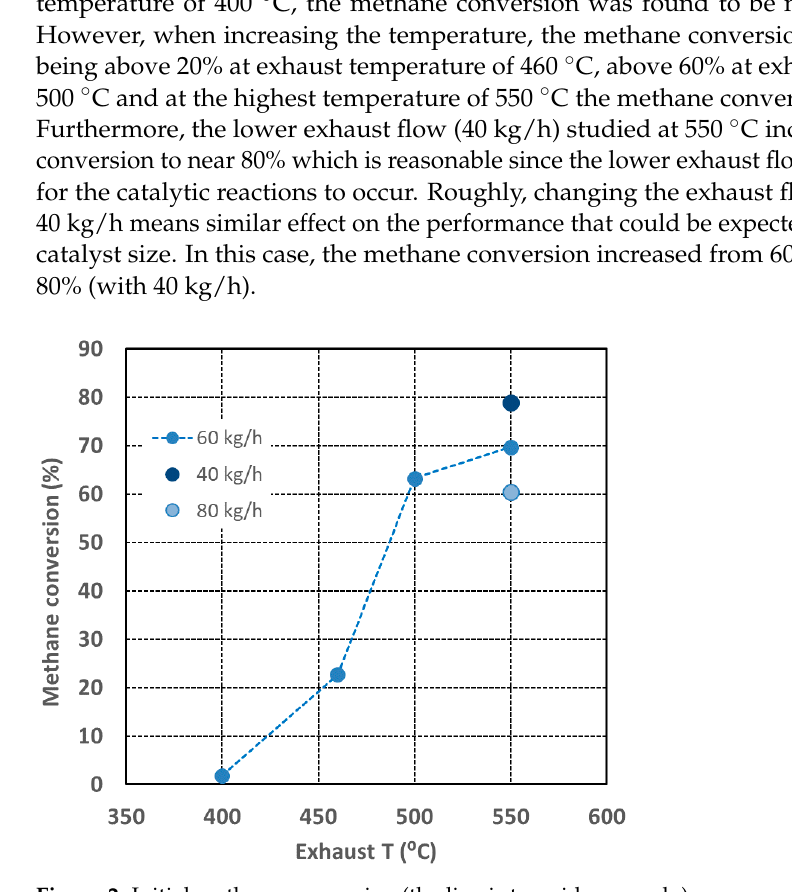
Figure 2. Initial methane conversion (the line is to guide eye only).